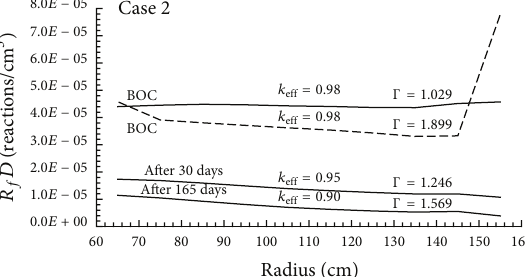
Figure 8: Variations of fission densities in the fuel core at the beginning and at the end of the cycle versus the core radius (solid lines indicate the flattened power